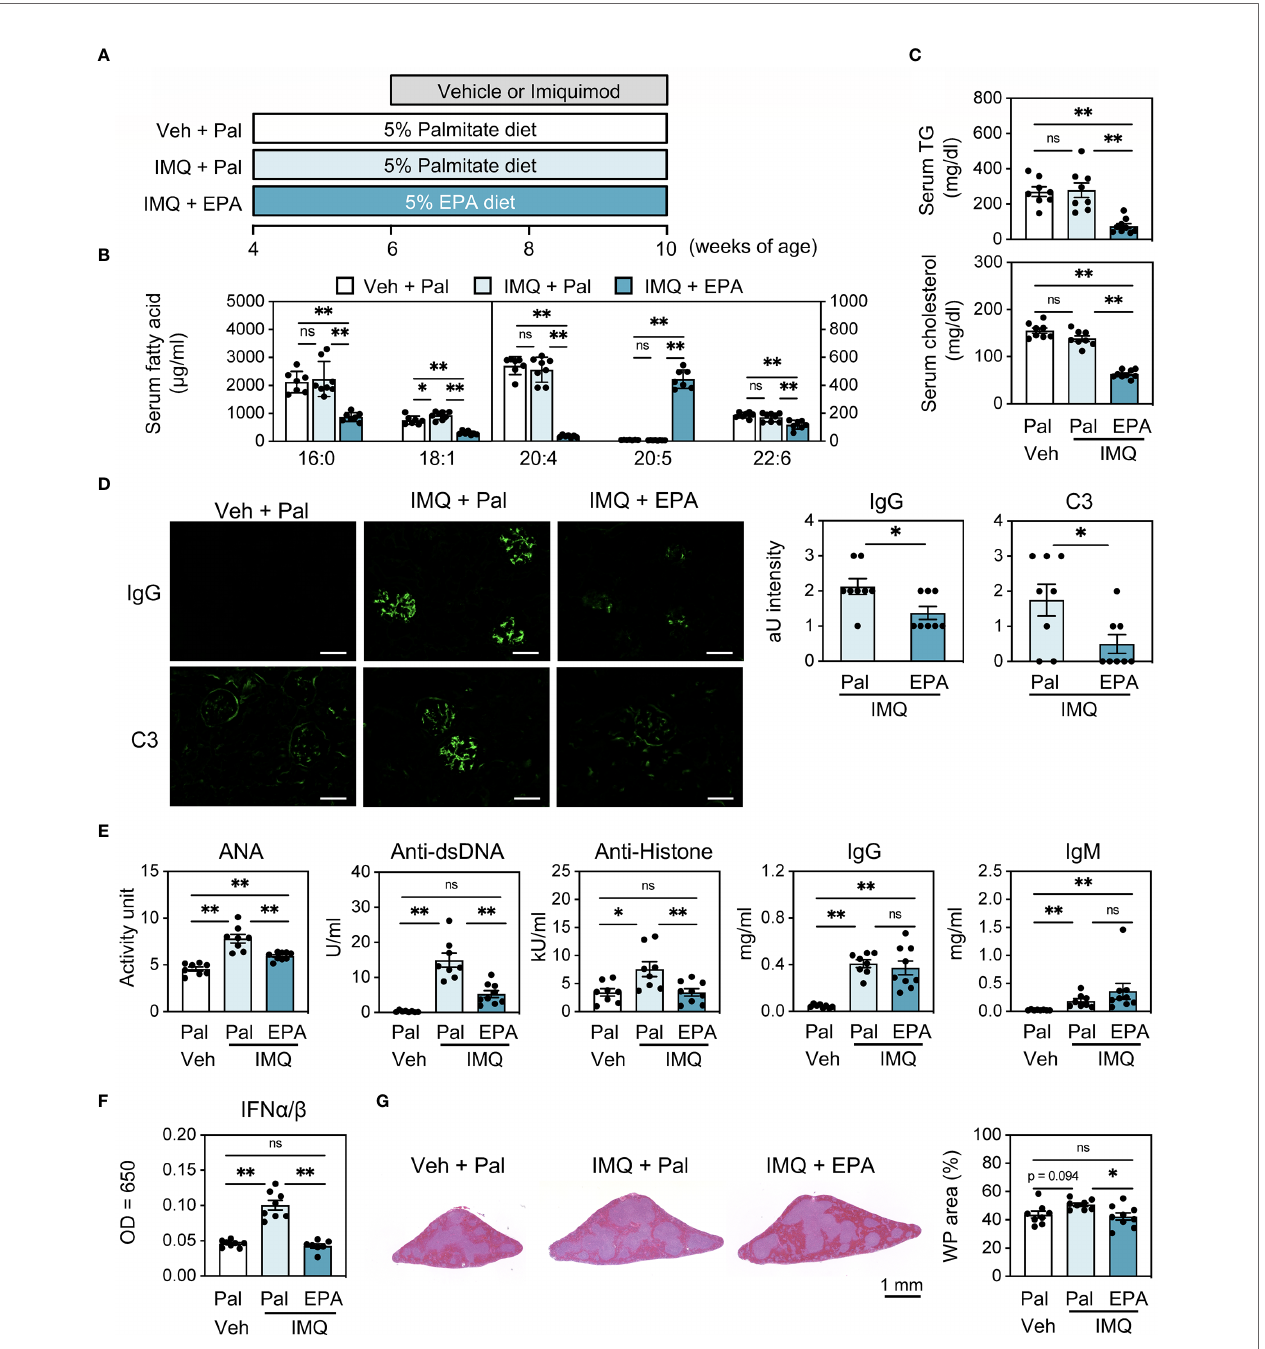
FIGURE 1 | EPA supplementation attenuates autoimmunity in imiquimod (IMQ)-induced lupus mice. (A) Experimental protocol. Four week-old FVB/N mice were fed chow diet supplemented with 5% ( wt/wt ) palmitate (Pal) or eicosapentaenoic acid (EPA) for 6 weeks. To induce lupus, the mice received IMQ or vehicle (Veh) treatment 3 times a week during the last 4 weeks. (B, C) Serum levels of fatty acid (B) , triglyceride (TG) ( C , top) and total cholesterol ( C , bottom). (D) Immunostaining of FITC-labeled anti-mouse IgG or C3 in kidney (left) and quanti fi cation of IgG and C3 deposition (right). Original magni fi cation: × 400, Scale bars represent 50 m m. (E) Serum levels of anti-nuclear antibodies (ANA), anti-dsDNA antibodies, anti-histone antibodies, total IgG and IgM. (F) Serum IFN a / b levels. (G) H&E staining of spleen sections (left) and quanti fi cation of white pulp (WP) area in whole spleen area (right). Veh + Pal, n = 8; IMQ + Pal, n = 8; IMQ + EPA, n = 9. Data shown are mean value ± SEM of representative experiments at least three times independently. Statistical analysis was performed with Dunn ’ s test (E: IgM) or Tukey ’ s test (if not otherwise stated). *p < 0.05; **p < 0.01; ns, not signi fi cant. See also Figure S1